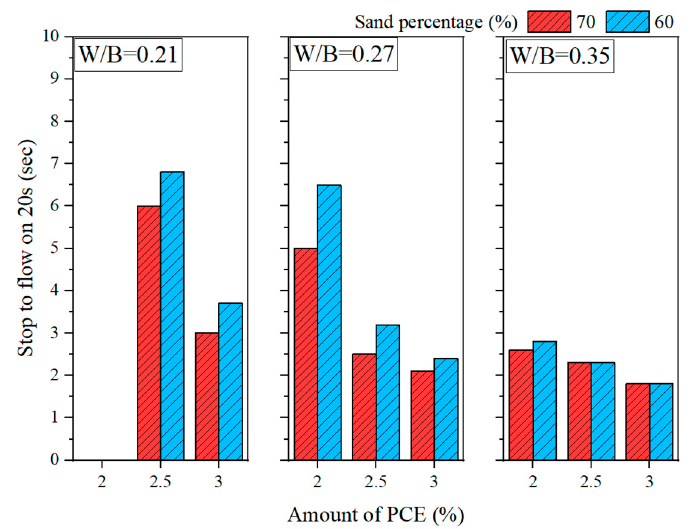
Figure 1. The time required for the flow of PCE to 20 cm.